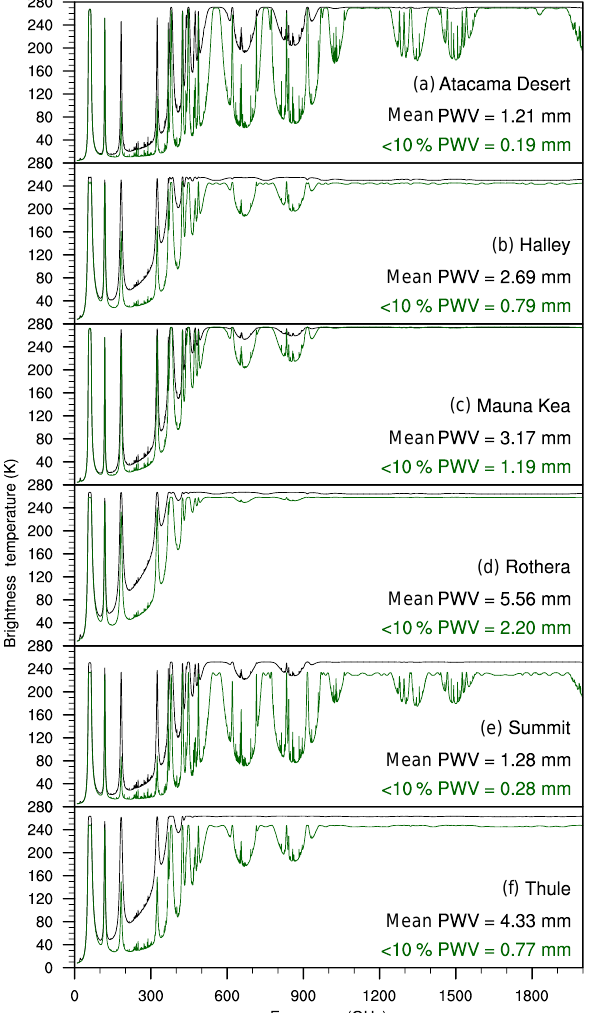
Figure 7. Simulated downwelling brightness temperatures as viewed from the ground for all six locations (a–f) Zenith angle=0 ◦ . The two scenarios shown are the annual mean (black curve) and the 10% driest profiles (green curve). The mean and the lower dectile PWV are shown for each